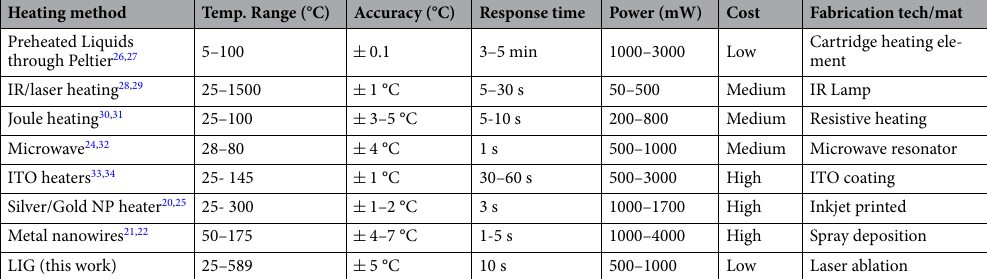
Table 1. Few Existing heating techniques employed in